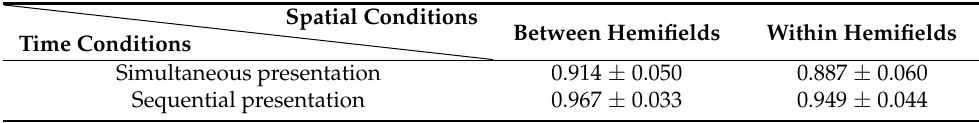
Table 1. Tracking accuracy (M ± SD, N = 33).